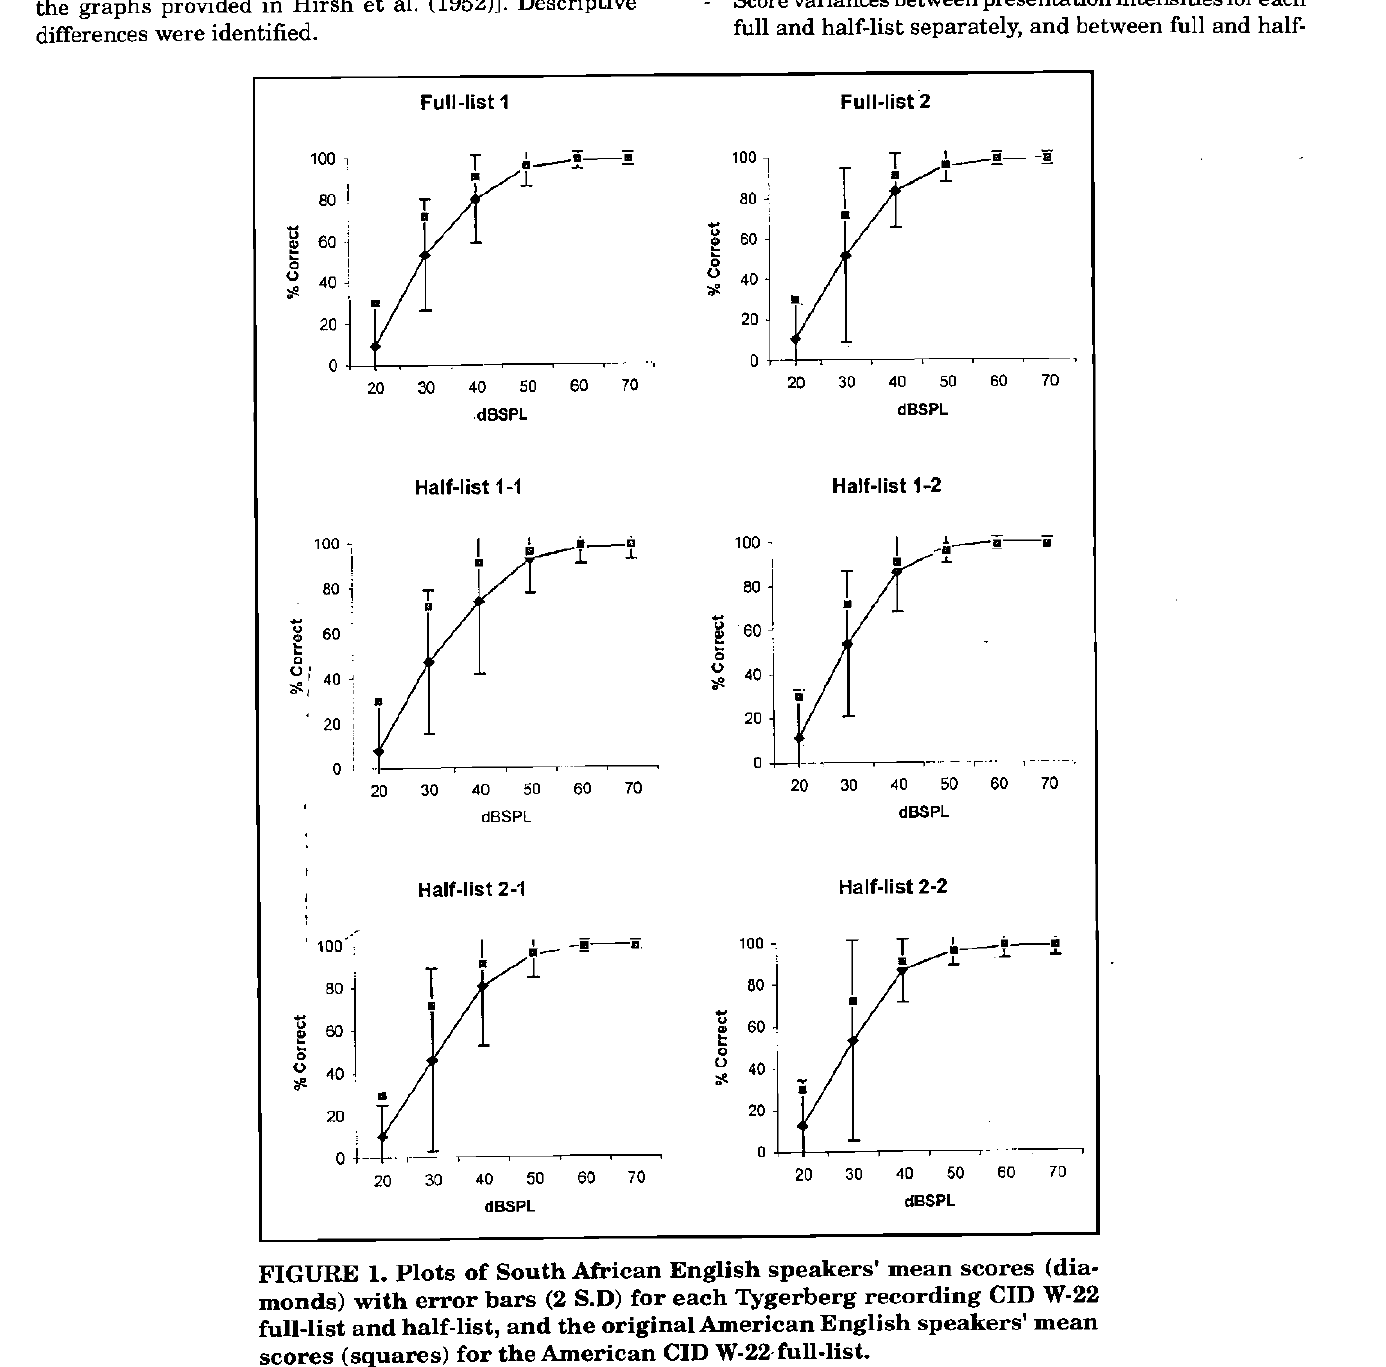
FIGURE 1. Plots of South African English speakers' mean scores (dia- monds) with error bars (2 S.D) for each Tygerberg recording CID W-22 full-list and half-list, and the original American English speakers' mean scores (squares) for the American CID W-22